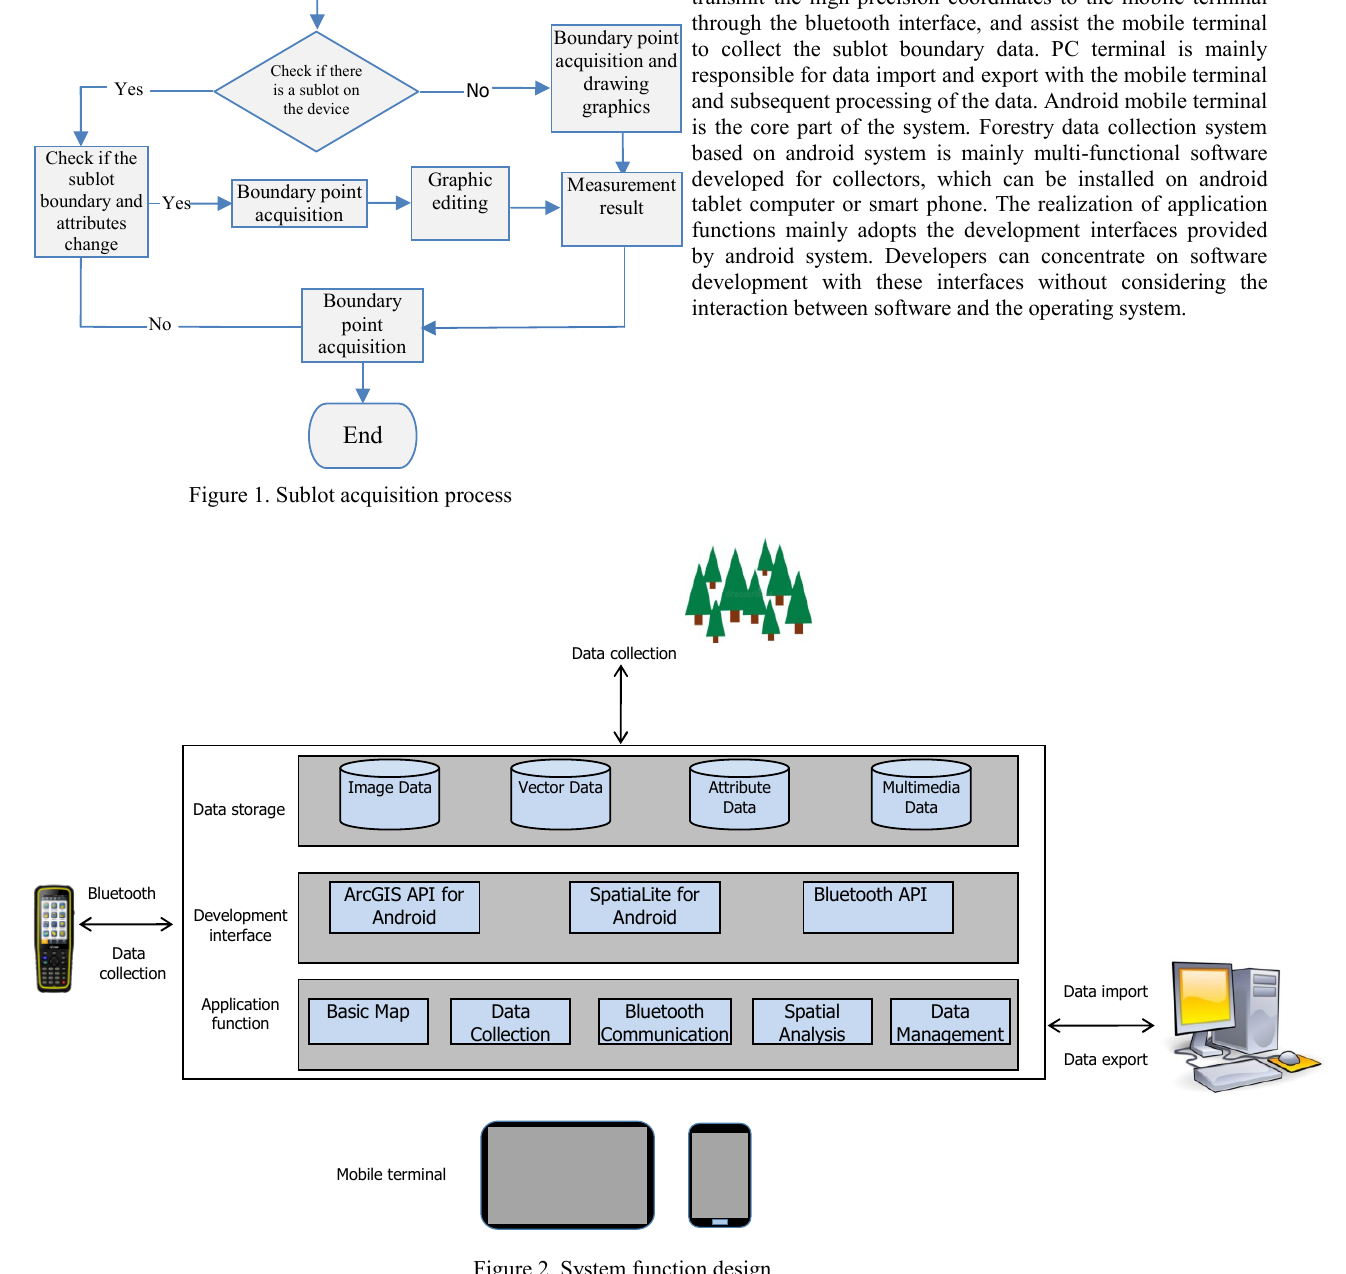
Figure 2. System function